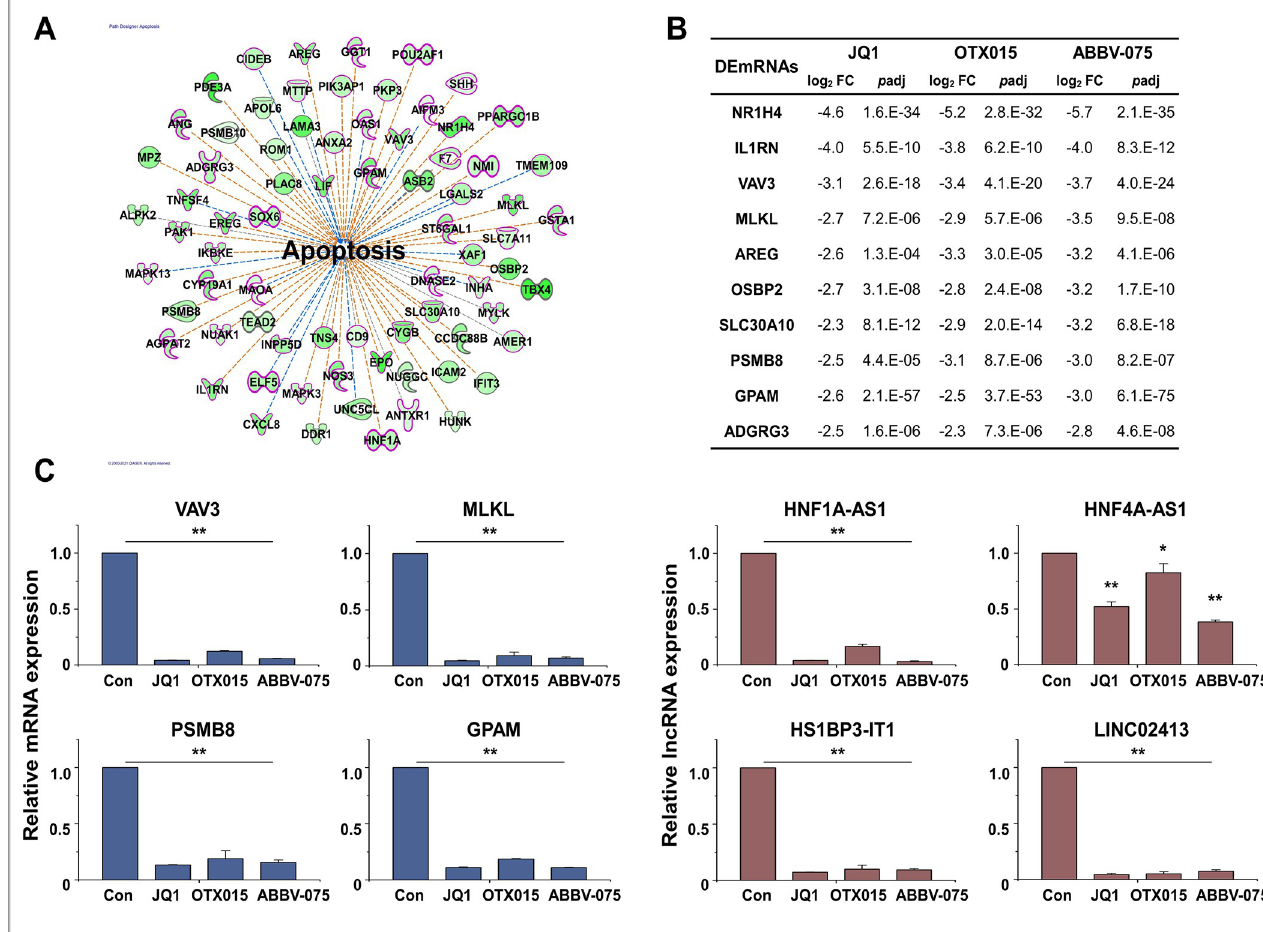
Fig 6. Biofunctional analysis of DEmRNAs related to apoptosis. (A) IPA downstream effects analysis showing the mapping of most significant genes related to apoptosis from the results of the biofunctional analysis in Module 1. Of the genes related to apoptosis, only cell death and survival-related genes are shown in bold and red. (B) Log 2 fold changes and p adj in the expression of genes related to apoptosis. (C) Expression levels of apoptosis-related mRNAs and lncRNAs were analyzed by qRT-PCR and normalized to GAPDH or U6 transcript levels, respectively. Overall, the apoptosis-related mRNAs and lncRNAs were inhibited by BET inhibitors. The data represent three independent experiments. The values are the mean ± SD of triplicate experiments ( � p < 0.05 and �� p <